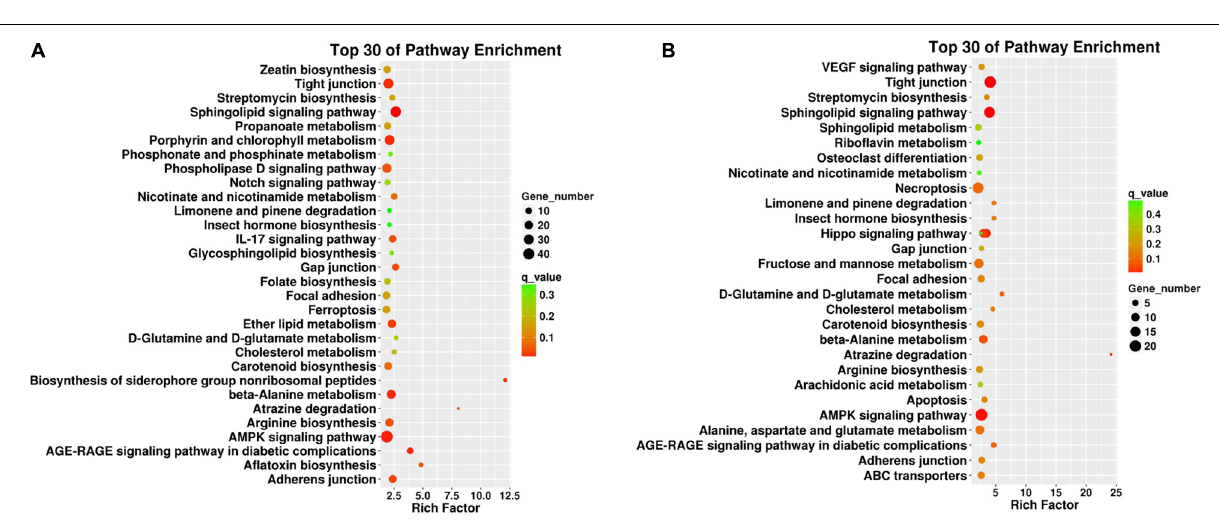
FIGURE 6 | Top 30 pathway enrichment results from the KEGG analyses in different plant tissues such as (A) roots and (B) leaves. The x-axis indicates the rich factor of such KEGG terms in each tissue. The color of the point indicates the q-value of the KEGG terms, and the size of the point indicates the number of genes enrich in such KEGG